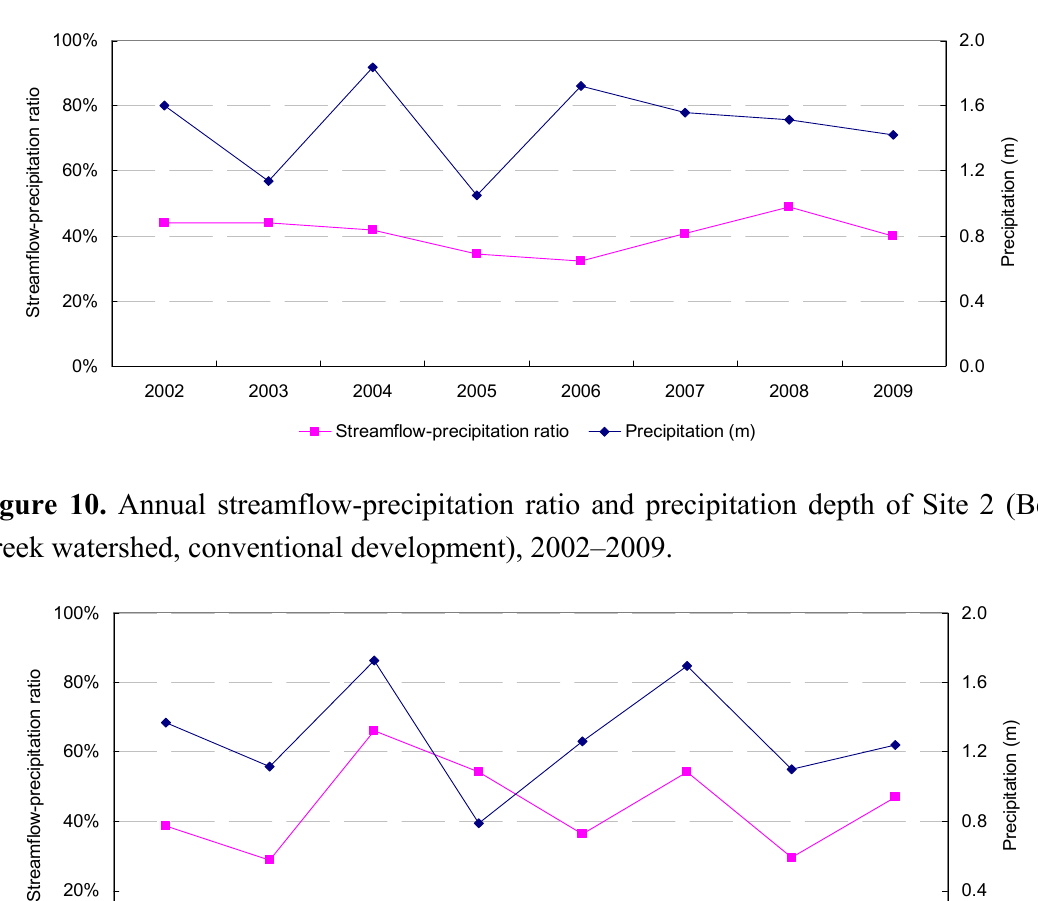
Figure 9. Annual streamflow-precipitation ratio and precipitation depth of Site 1 (Panther Creek watershed, The Woodlands green infrastructure development), 2002–2009.